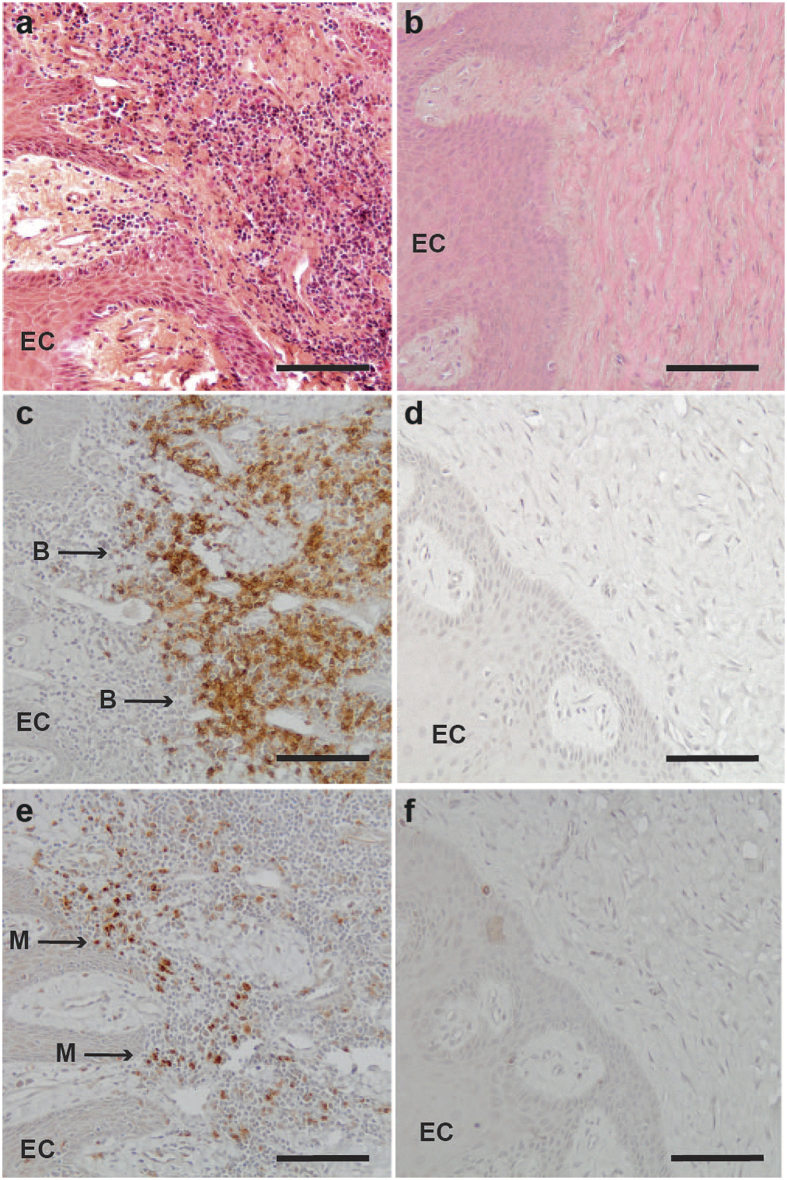
Histological and immunohistological staining of gingival biopsies from patients with periodontitis and healthy control subjects.(a) Representative Hematoxylin-Eosin (H&E) staining of gingival tissue from a patient with periodontitis and (b) a healthy control subject. Representative immunohistological staining with (c,d) CD20, a B plasma cell marker, and (e,f) CD68, a macrophage marker, of gingival tissue from a patient with periodontitis and a healthy control subject. EC = epithelial cells, B = B cells, M = macrophages. Scale bars = 100 μm.